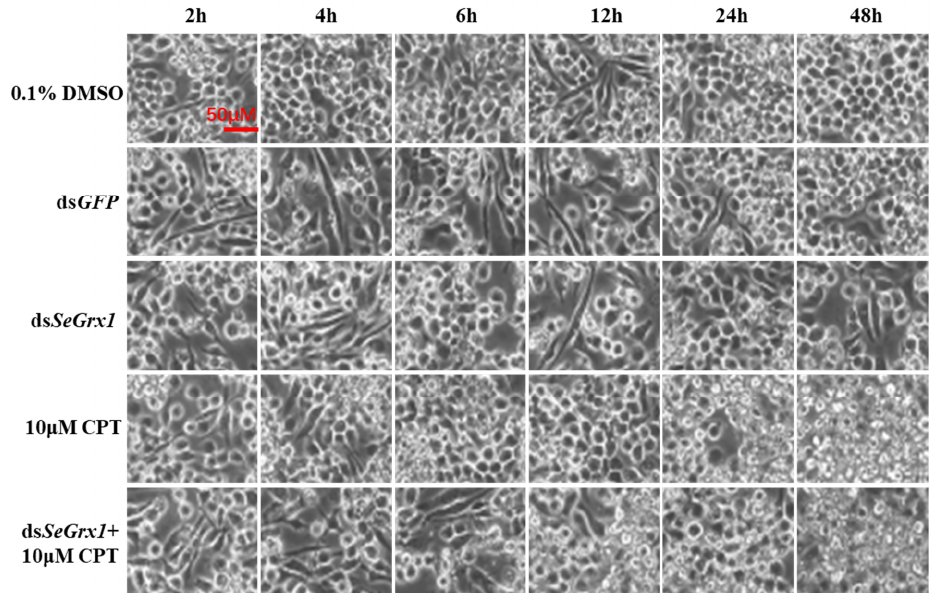
Figure 2. Morphology observation of IOZCAS-Spex-II cells treated with ds GFP , ds SeGrx1 , 10 μM CPT, and de SeGrx1 + 10μM CPT. 0.1% DMSO was used as a control. The scale bar is 50 μm. The morphological changes of IOZCAS-Spex-II cell were recorded by an inverted phase contrast microscope with 400 × magnification (IX53, Olympus, Tokyo, Japan).